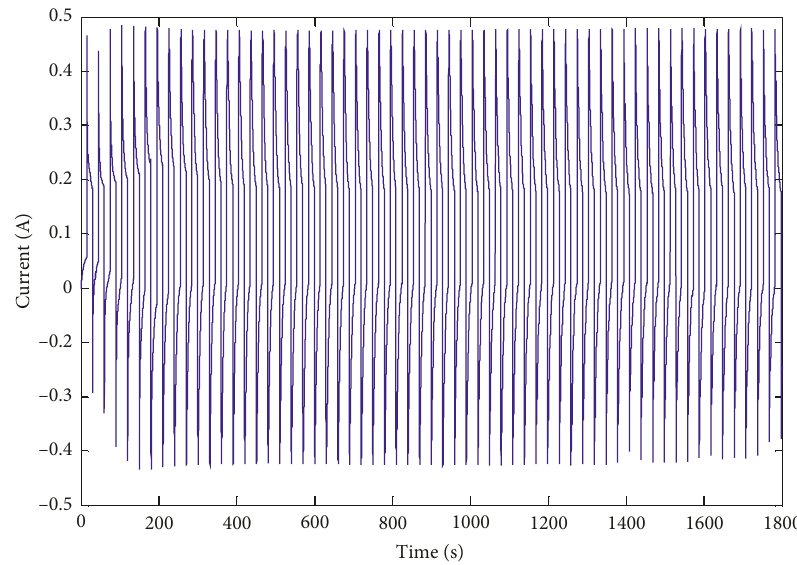
Figure 16: Current response curve of the soft